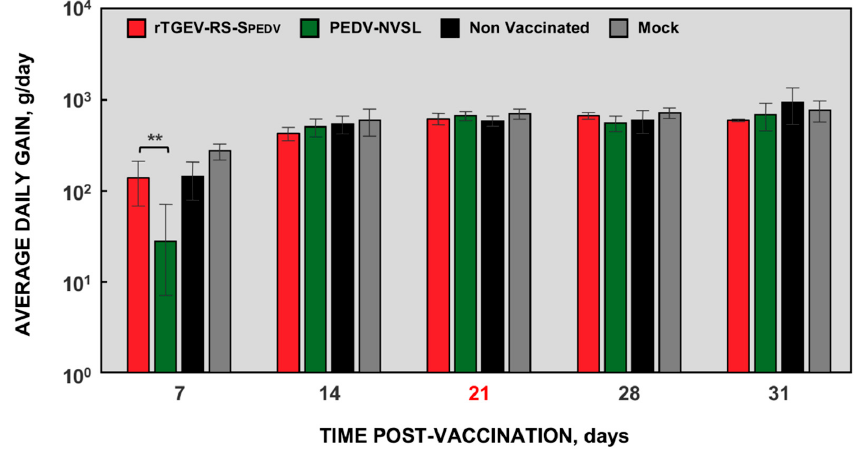
Figure 6. Weight gain in vaccinated animals. Three-week-old pigs were divided into four groups. Animals from two groups were vaccinated with 10 6 TCID 50 / animal of rTGEV-RS-SPEDV virus (red) or a virulent US PEDV strain (PEDV-NVSL, green). Three weeks after vaccination (21 dpv indicated in red), non-vaccinated animals were either mock infected (Mock, grey) or challenged with 10 7 TCID 50 / animal of a virulent PEDV strain (Non Vaccinated, black). Vaccinated animals were also challenged with the same dose as non-vaccinated animals. Clinical signs and weight were observed daily after vaccination and challenge, and once per week during the course of the experiment. Average daily gain represents the mean from six different animals. Error bars represent the standard deviation for each value; p value, ** <0.01.